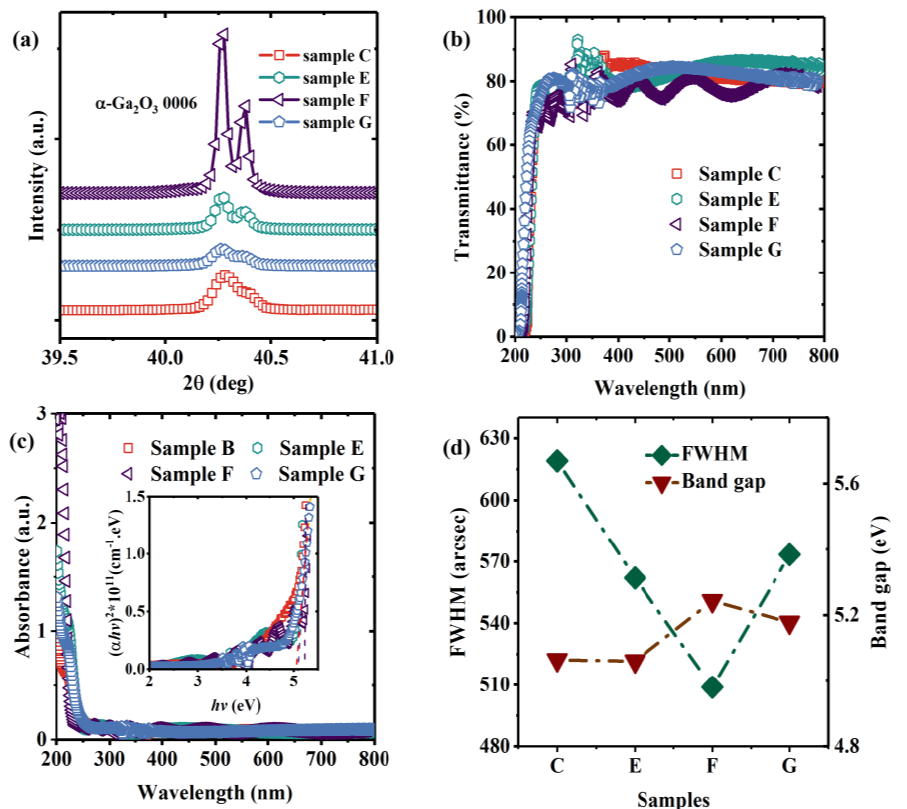
Figure 5. ( a ) XRD θ - 2θ diffraction profiles for α -Ga 2 O 3 films grown under different carrier gas flow rates and types; ( b ) optical transmittance, ( c ) optical absorption spectra, ( d ) bandgaps and FWHMs of α -Ga 2 O 3 films.